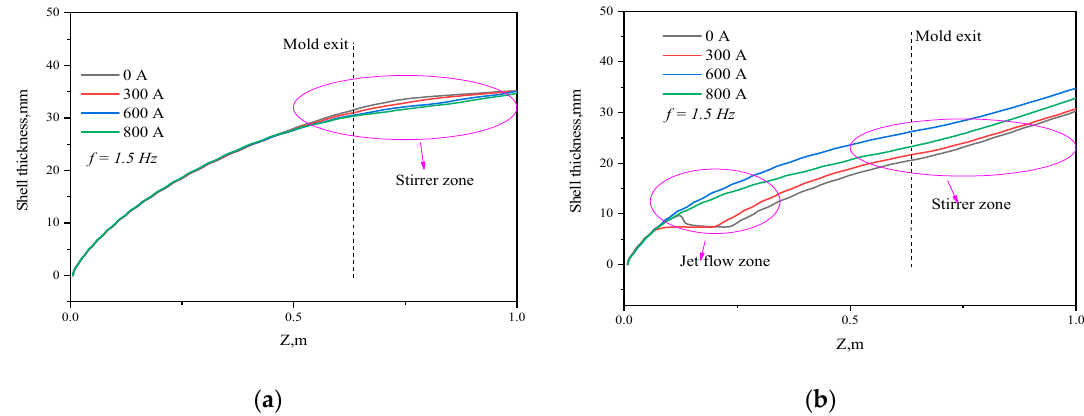
Figure 7. Shell thickness along the casting direction: ( a ) Y = 0 mm plane in single-port nozzle; ( b ) Y = 205 mm plane in five-port nozzle.